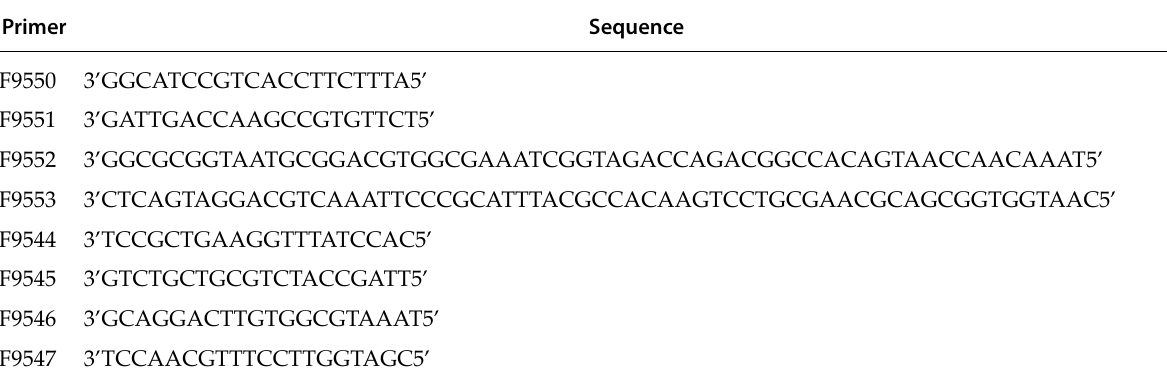
Table 1. Primers used for sequence analysis of the Agrobacterium fabrum mutant.